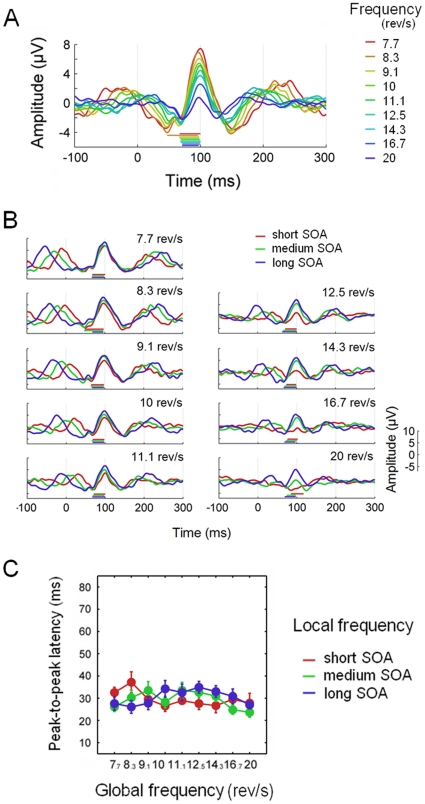
Effect of global and local stimulation frequency on the shape of recorded ERPs.
A, Grand-average ERPs for the jitter conditions of Experiment 2. The solid bars along the horizontal axed indicate the peak-to-peak (N75-P100) latency. B, Grand-average ERPs for trials grouped by their immediately past SOA at each stimulation rate. C, Peak-to-peak latencies as a function of both global and local stimulation frequency. The error bars indicate the standard error of the mean across subjects.